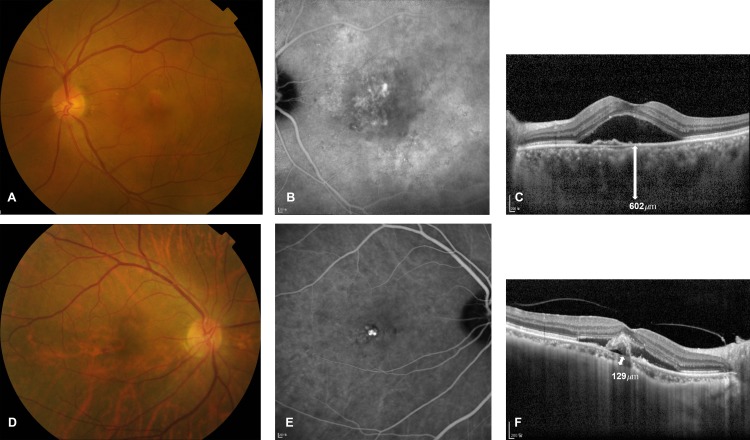
Imaging features of eyes having thick or thin choroid.(A-C) Left eye of a 66 year old man in the thick group. (A) Color photograph showed no fundus tessellation, and (B) late phase indocyanine green angiography (ICGA) image showed hyperfluorescent areas indicating the presence of choroidal hyperpermeability. (C) Subfoveal choroid was thick (white arrow) on enhanced depth imaging optical coherence tomography (EDI OCT) image. (D-F) Right eye of a 70 year old woman in the thin group. (D) Color photograph showed fundus tessellation, and (E) late phase ICGA image revealed the absence of choroidal hyperpermeability. (F) Subfoveal choroid was thin (white arrow) on EDI OCT image.